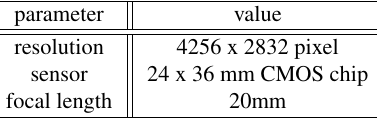
Table 1: Data of camera and lens